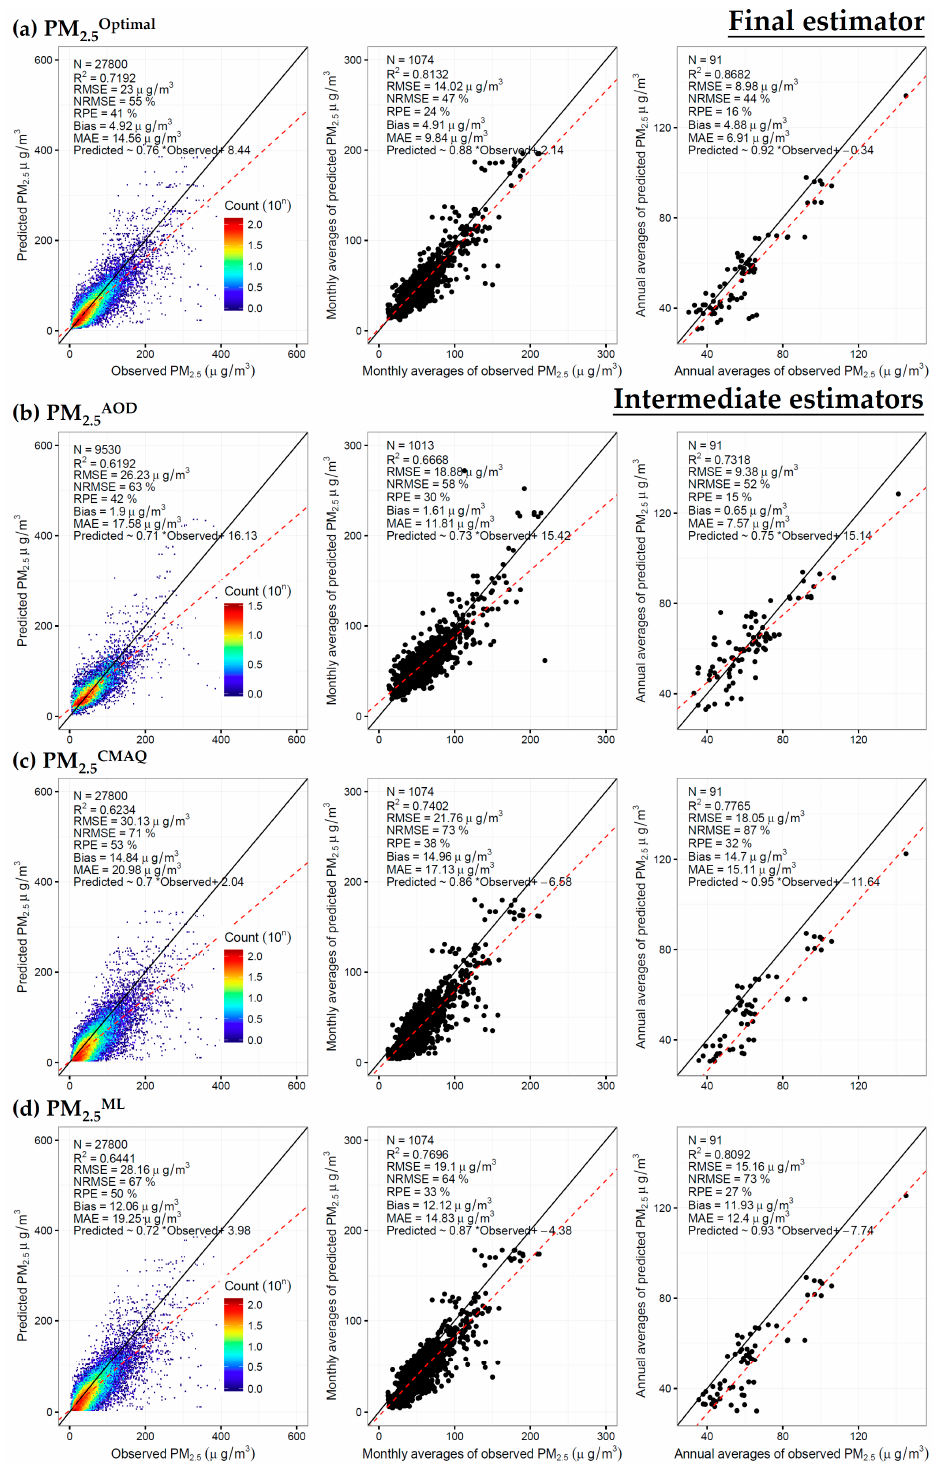
Figure 4. Scatterplots of cross-validated values and their monthly or annual averages for final estimator (PM 2.5Optimal ) and intermediate estimators of the three-stage model (PM 2.5AOD , PM 2.5CMAQ and PM 2.5ML ).